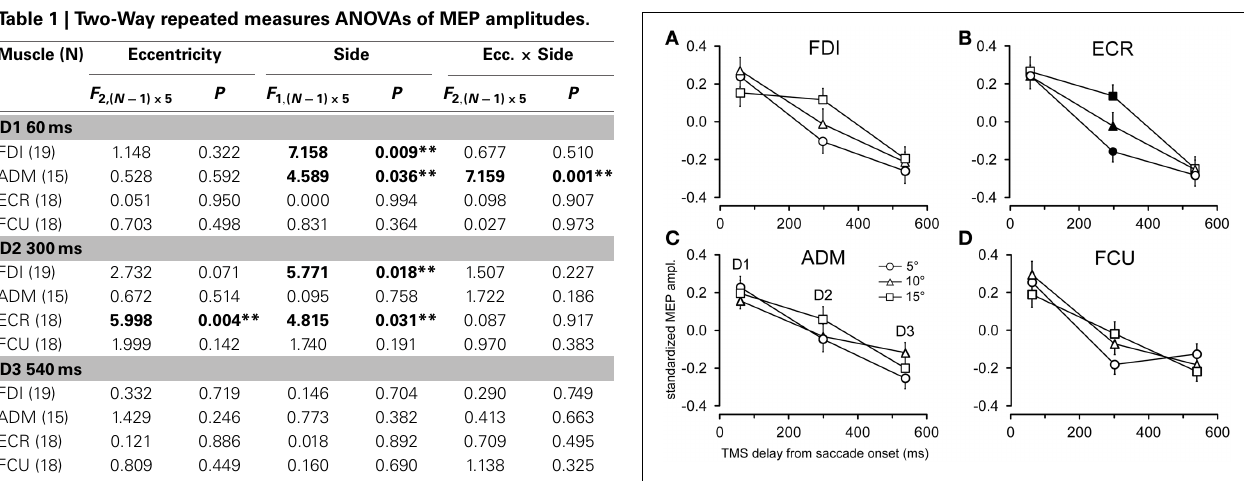
FIGURE 5 | Effects of target eccentricity on MEP amplitude. Mean MEP amplitudes across subjects are shown as a function of TMS delay for target eccentricities of 5 ◦ , 10 ◦ , and 15 ◦ , irrespective of the visual hemi-field of stimulus presentation, in the FDI (A) , ECR (B) , ADM (C) , and FCU (D) muscles. Filled symbols denote a statistically significant difference between MEP amplitudes at a given TMS delay. Error bars represent the standard error of the mean.